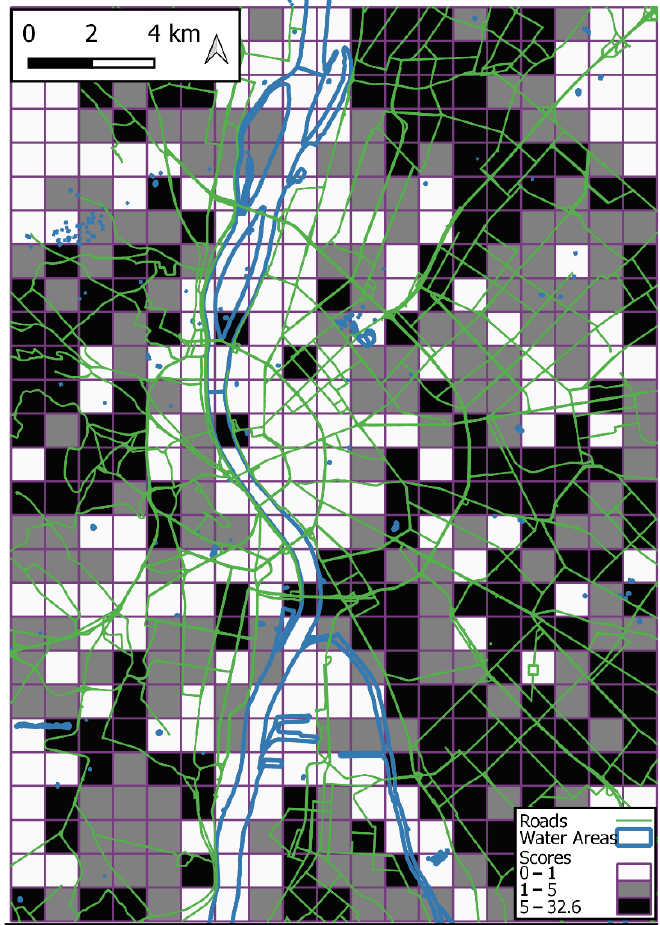
Figure 3. Priority Levels of New Bike Docks.